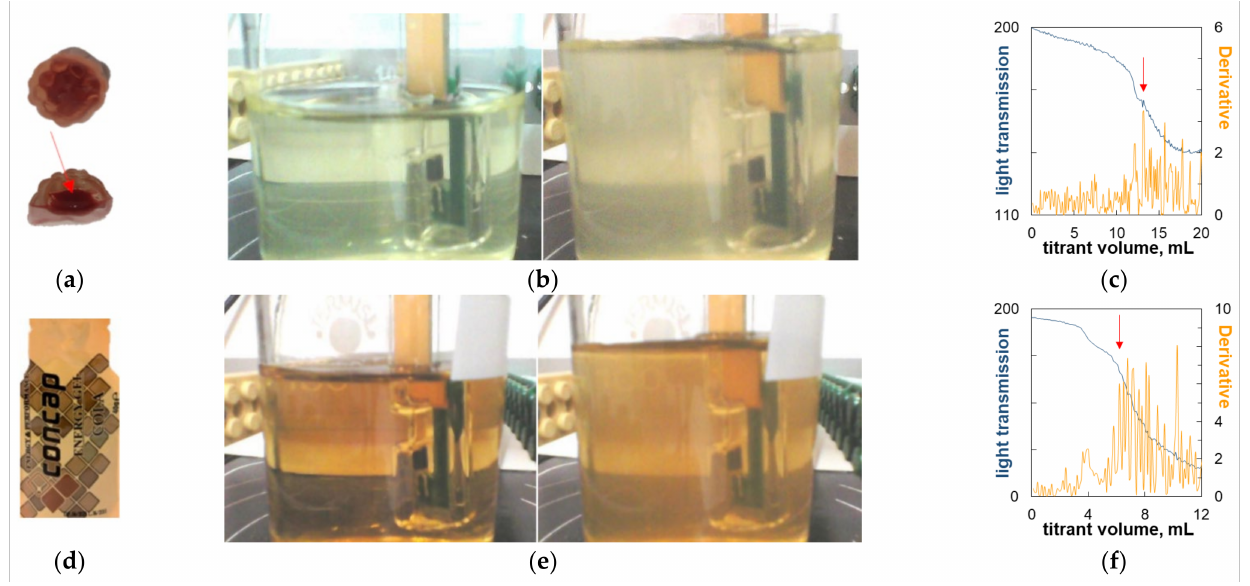
Figure 10. Illustration of the determination of carrageenan in commercial samples. ( a ) Haribo (the analyzed part of the product is indicated by an arrow) and ( d ) energy gel, using immersion probe; ( b , e ) analyte solution before titration ( left ) and at the endpoint ( right ); ( c , f ) titration curves (the color of the line corresponds to the color of the description of the vertical axis; the arrow indicates the endpoint of the